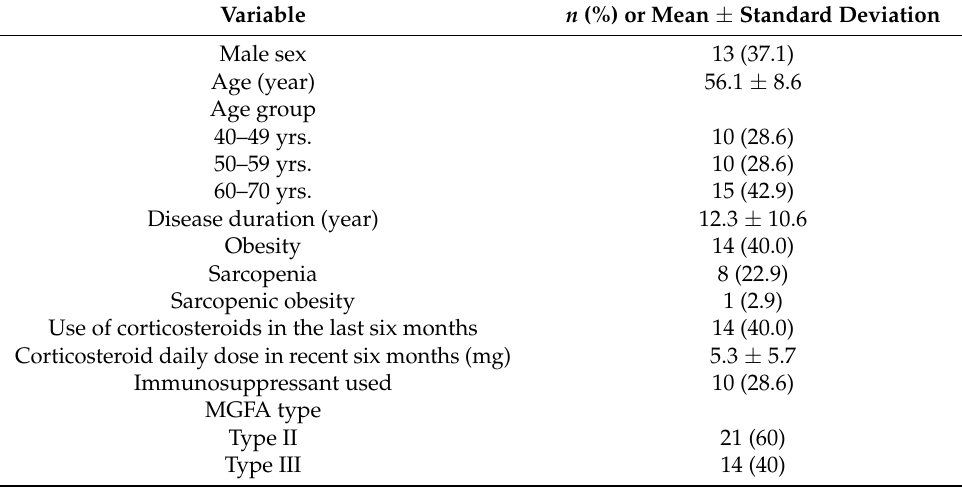
Table 1. Clinical features of the 35 patients with myasthenia